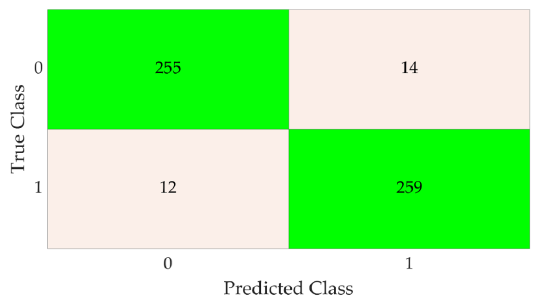
Figure 8. The confusion matrix of the constructed SVM model.